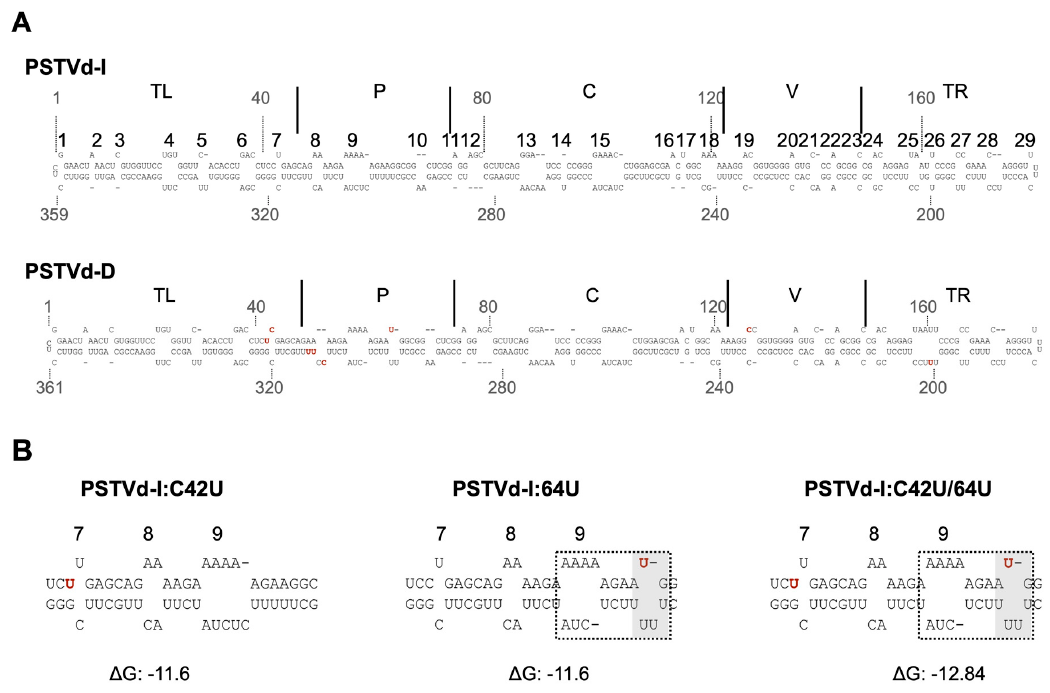
Figure 3. In silico secondary structure prediction of PSTVd mutants. Secondary structure of PSTVd-I wt , PSTVd-D wt , PSTVd-I:C42U, PSTVd-I:64U, and PSTVd-I:C42U / 64U are predicted in silico using mfold webserver. ( A ) Full-length structure of PSTVd-I wt and PSTVd-D wt are presented. The structural / functional domains of PSTVd: Terminal left (TL), Pathogenicity (P), Central (C), Variable (V), and Terminal right (TR), are delimited by the vertical solid lines and are named accordingly. The 29 loops are numbered from left to right on PSTVd-I. The red colored nucleotides on the PSTVd-D wt structure represents the nucleotides that are di ff erent from PSTVd-I wt . ( B ) Enlarged structure of PSTVd-I at the mutated region. The red color nucleotide indicates the mutated nucleotide. Structural changes observed against the PSTVd-I wt at the site of mutation are shown by a grey box. The dotted box indicates the structural deviation observed in mutants compared to the secondary structure of PSTVd-I. An online tool, PairFold, was used to predict the minimum secondary structure free energy of pairs of RNA